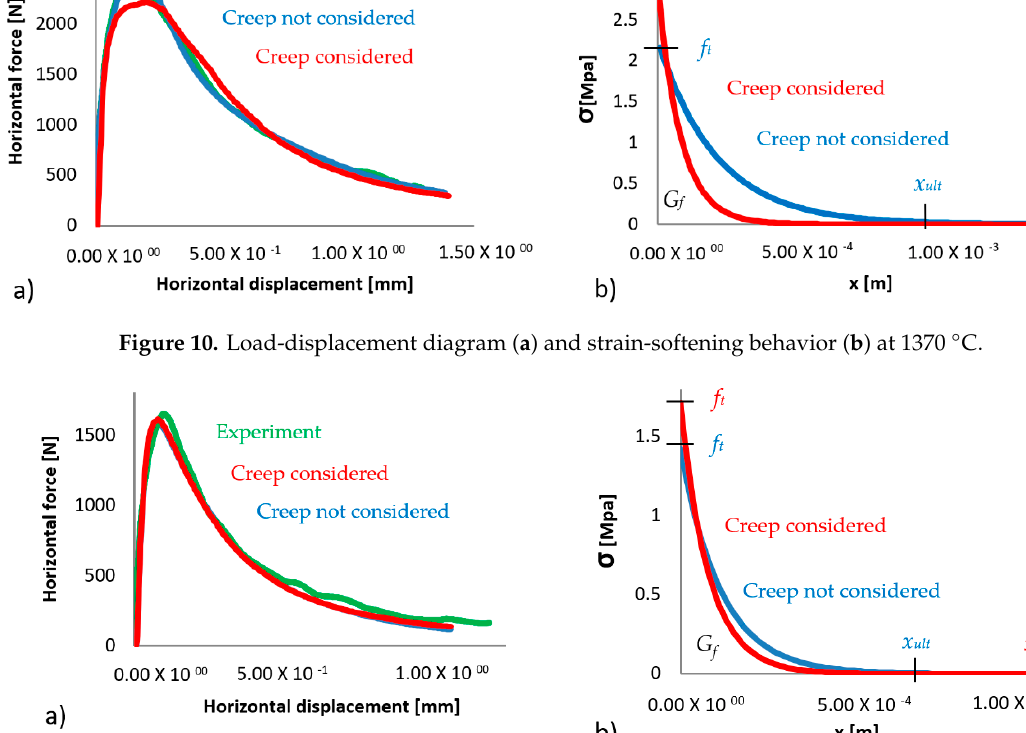
Figure 11. Load-displacement diagram ( a ) and strain-softening behavior ( b ) at 1100 °C.